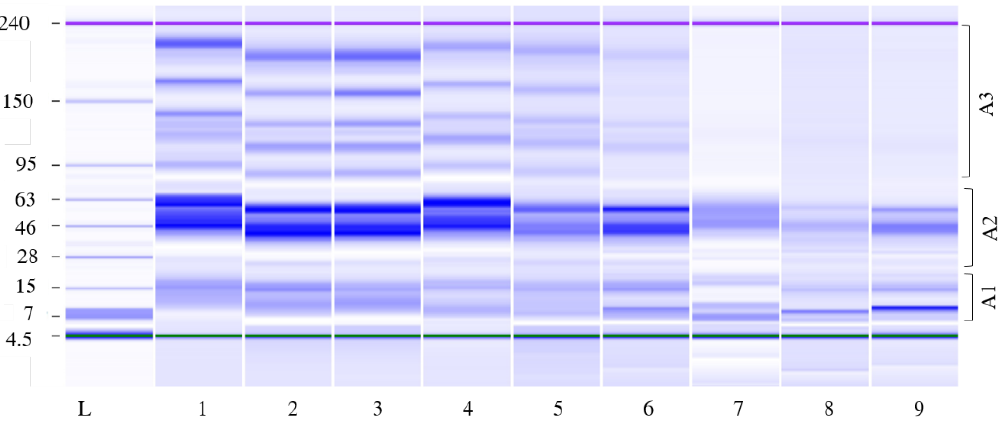
Figure 4. Electrophoretic analysis (LoaC) of total proteins extracted from liquid sourdough Bio21B samples during L. plantarum ITM21B fermentation shown as a gel-like image on Protein230 LabChip. Total proteins were extracted at fermentation times T0h (lanes 1, 2, and 3), T14h (lanes 4, 5, and 6), and T24h (lanes 7, 8, and 9) from Bio21B-1, Bio21B-2, and Bio21B-3, respectively; sizing Ladder (L). Numbered brackets indicate molecular weight areas: A1 (14–30 kDa), A2 (31–79 kDa), and A3 (80–230 kDa).